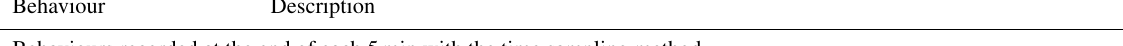
Table 1. Description of individual, feeding and abnormal behaviours investigated in the study. Behaviour Description